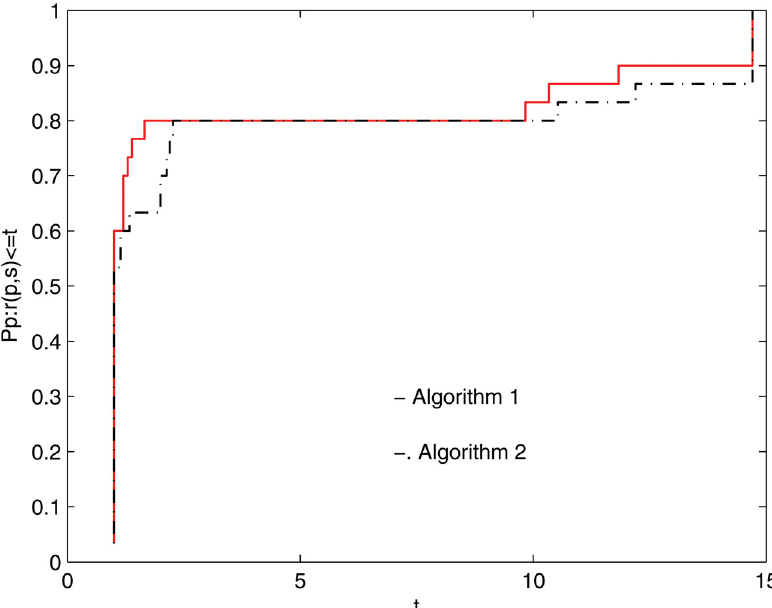
Fig 1. Performance profiles of these methods(NI).